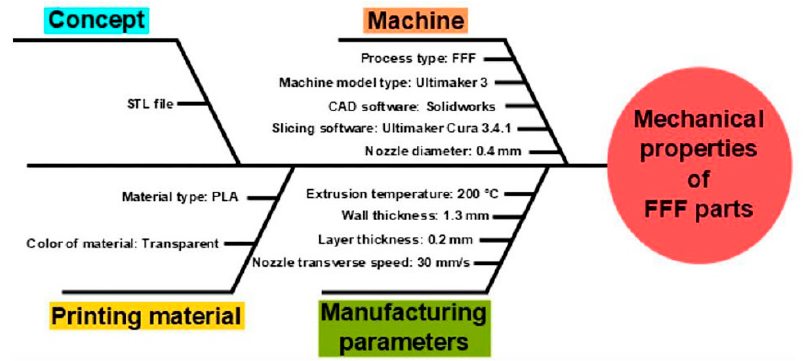
Figure 2. Summary of our research parameters that have a role on the resulting mechanical properties of FFF technology in Ishikawa diagram.